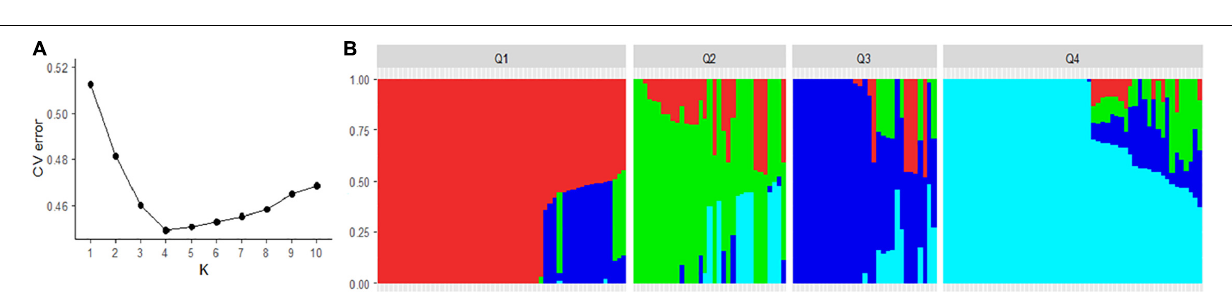
Frontiers in Plant Science |